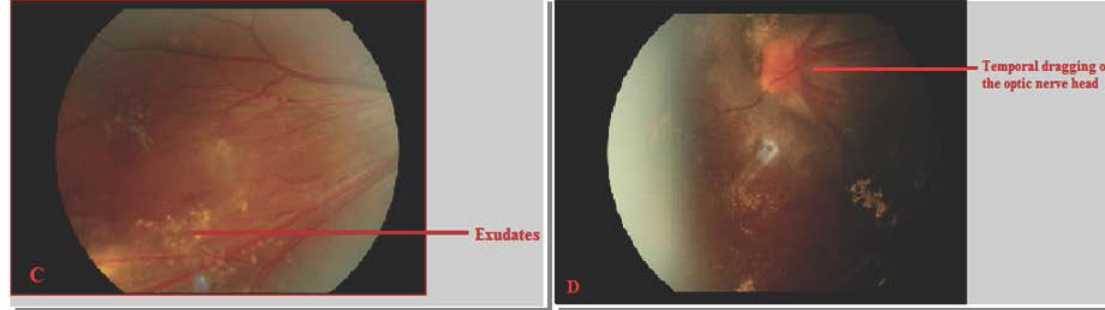
Figure 2C: showing exudates beneath the macula area and Figure 2D shows dragging of the optic nerve head in the left